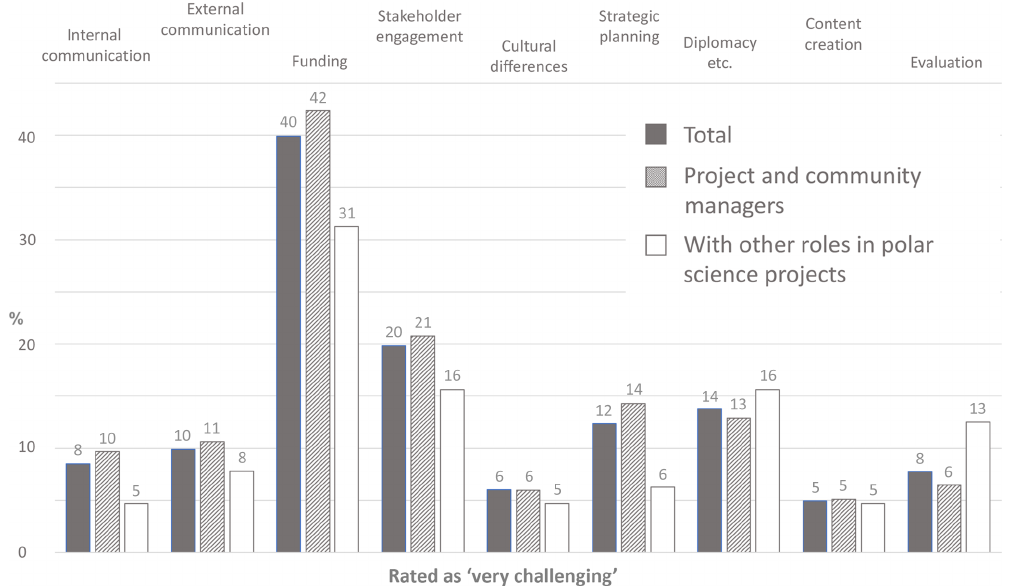
Figure 10. Challenges associated with Community Engagement. Survey respondents (%) rating as “5 – very challenging” when asked the questions Q14: Community: Please rate (from 1 to 5) the following